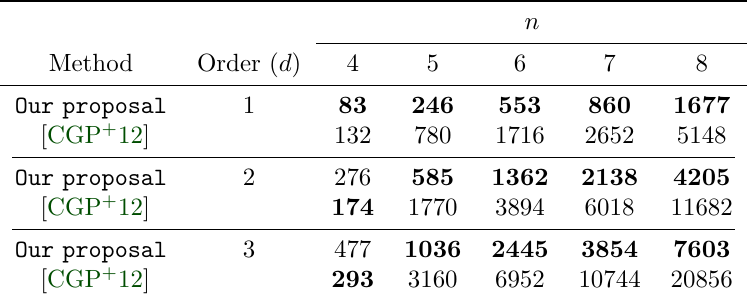
Table 4: Costs of evaluating S-boxes of size 4 ≤ n ≤ 8 with the cyclotomic method and our alternate